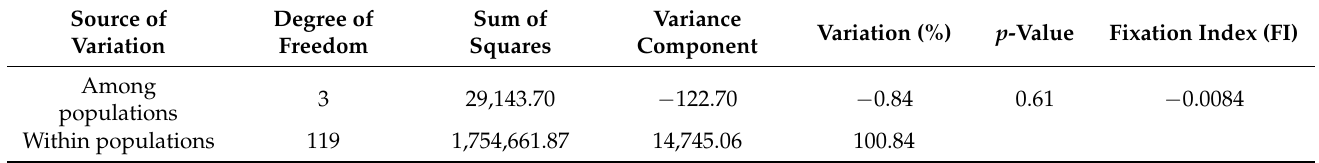
Table 9. Hierarchical analysis of molecular variance (AMOVA) in FG